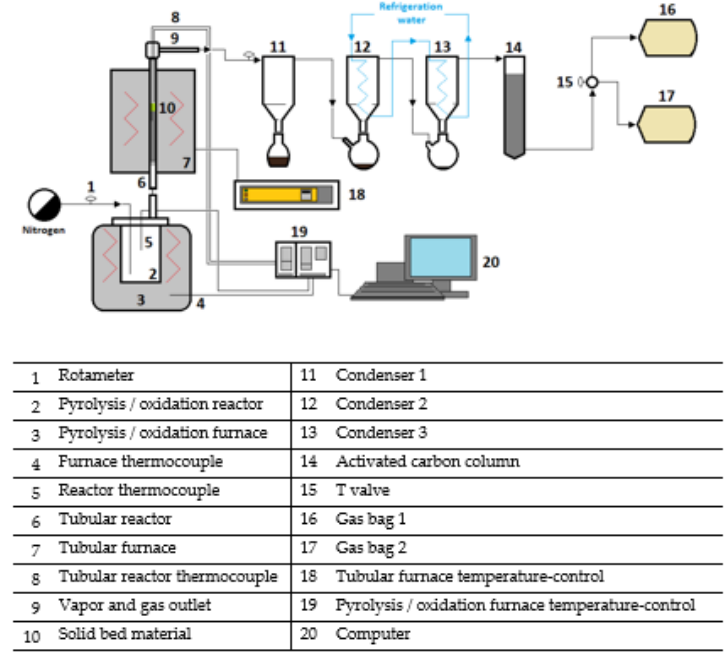
Figure 2. Flowsheet of the lab ‐ scale plant used for the torrefaction and carbonization experiments. A conceptual scheme of the experiments carried out is presented in Figure 3.